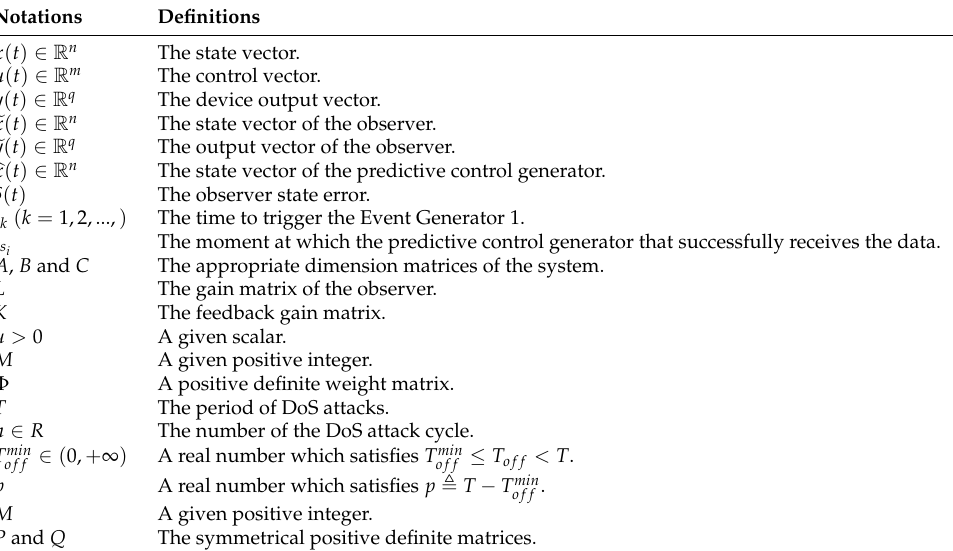
Table 1. All notations in this